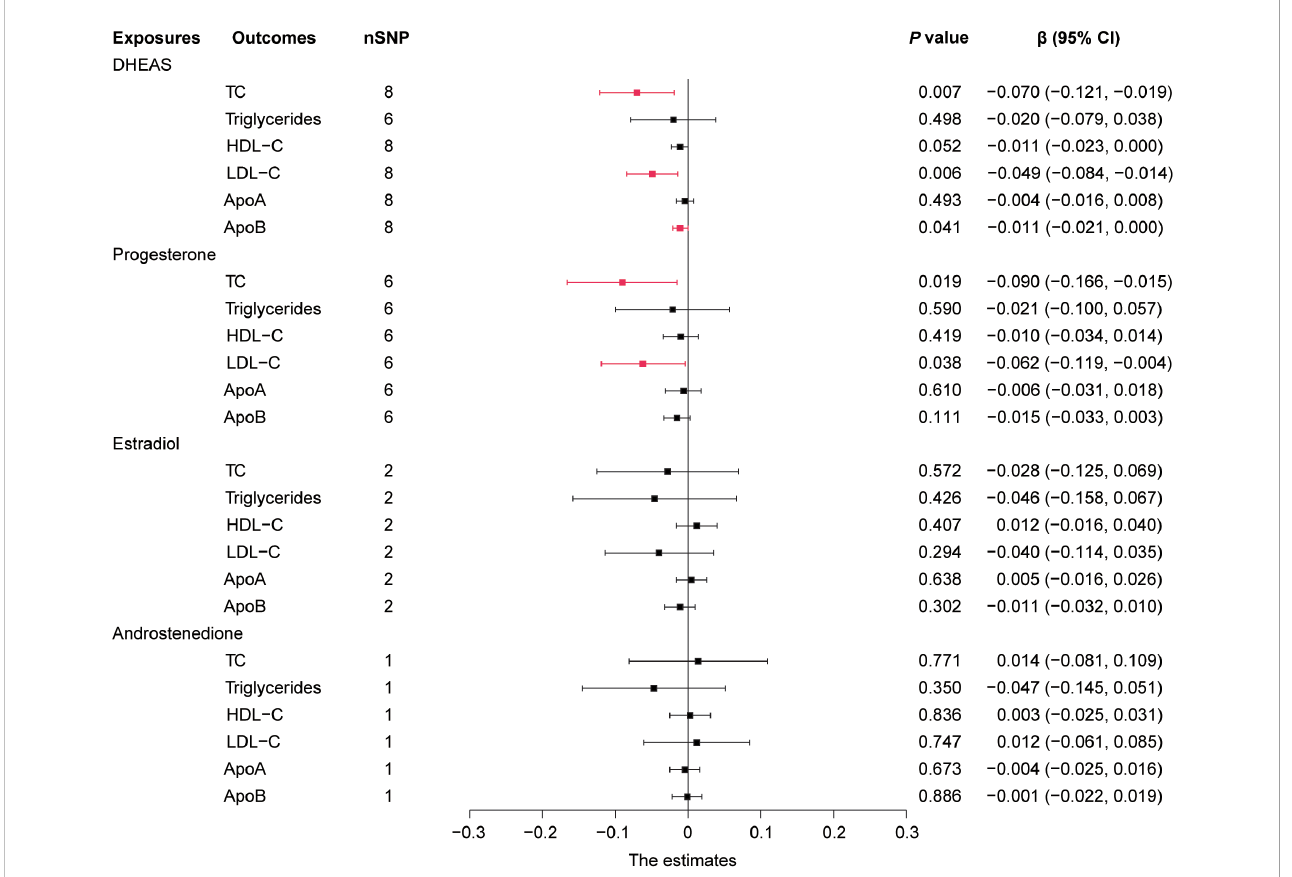
FIGURE 4 Forest plot of IVW estimates in males. DHEAS, dehydroepiandrosterone sulfate; nSNP, number of single-nucleotide polymorphisms; HDL-C, high-density lipoprotein cholesterol; LDL-C, low-density lipoprotein cholesterol; 95% CI, 95% con fi dence interval; IVW, inverse-variance weighted; TC, total